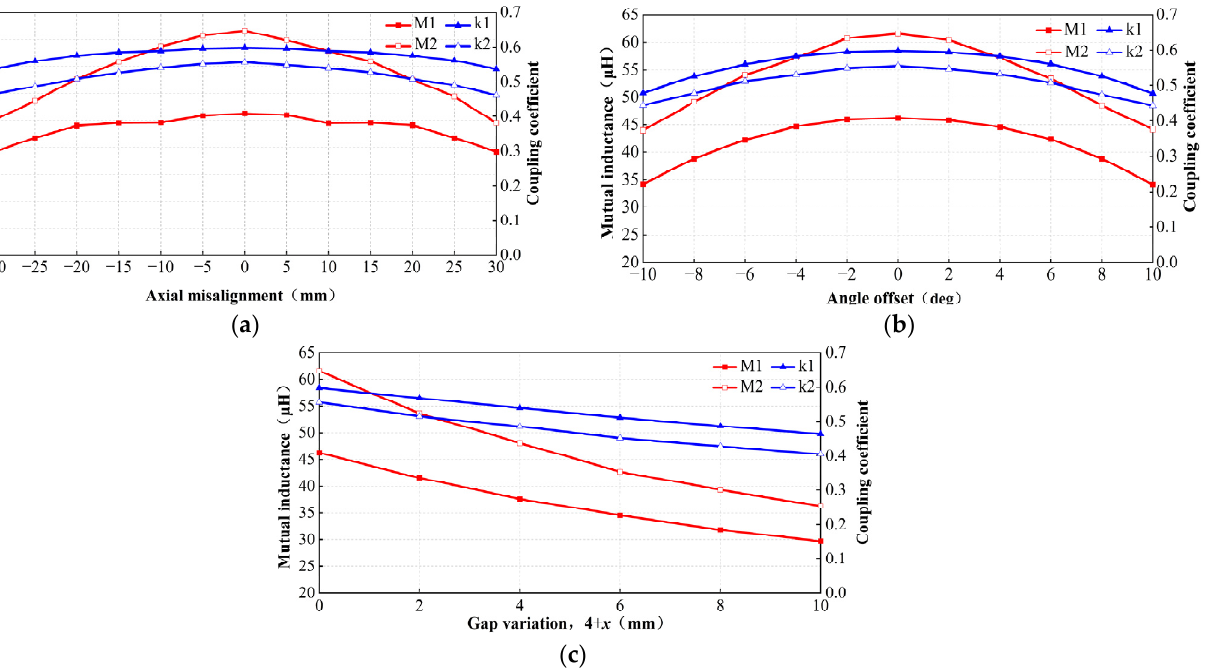
Figure 5. Static magnetic field clouds of two structures. ( a ) Arc-shaped core; ( b ) Double dipole core.